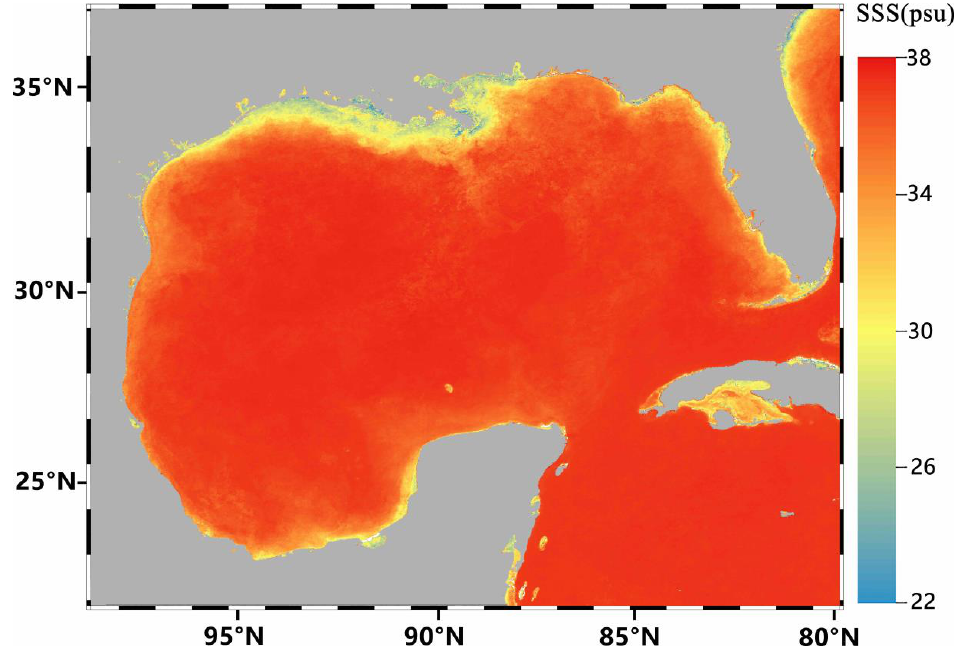
Figure 5. Annual SSS map generated by the cubist model, averaged from daily composed image within the cruise date range. Table 3. Cubist-generated linear models for each rule, reflecting the usage and weight of each variable.